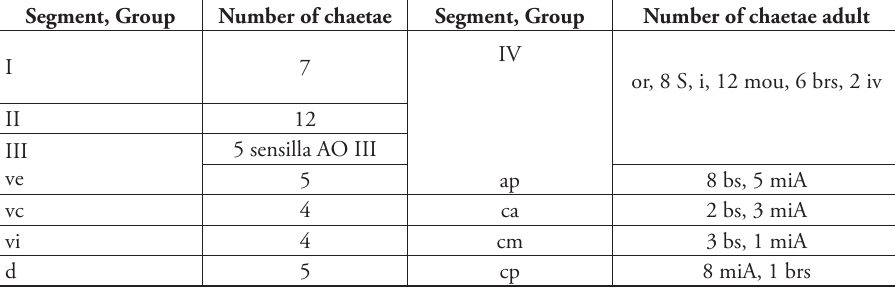
Table 1b. Chaetotaxy of Lobellina weinerae sp. n.: chaetotaxy of antennae. Segment, Group